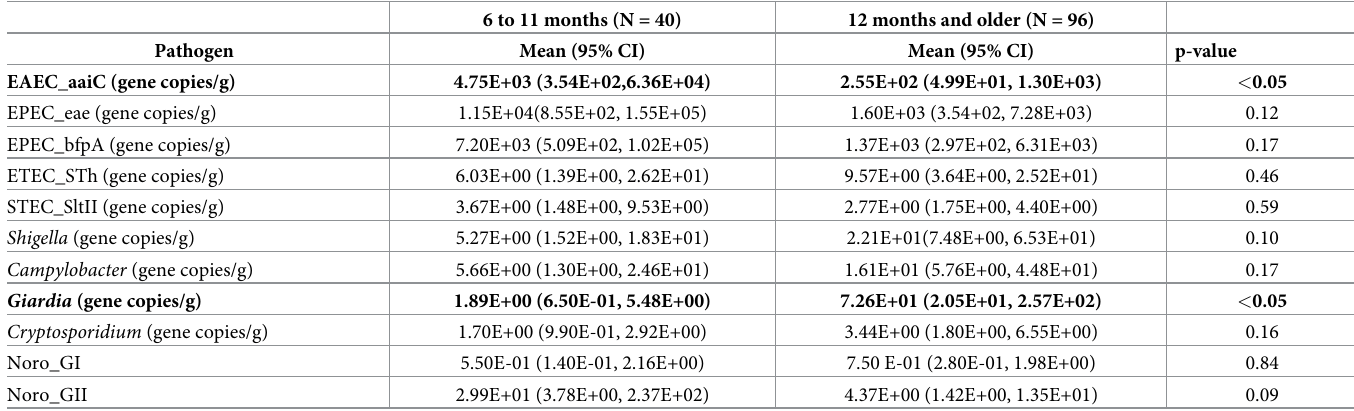
Table 2. Geometric means of pathogen stool gene counts by age category. Statistically significant differences in pathogen loads by age category are bolded. 6 to 11 months (N = 40) 12 months and older (N = 96)